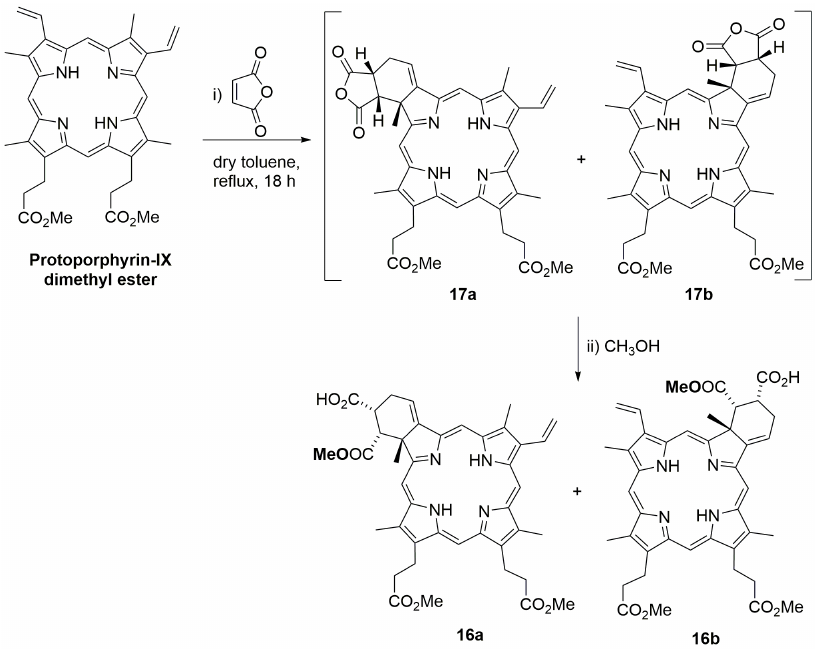
Figure 18 - Synthetic strategy to amphiphilic chlorin derivatives 16a,b